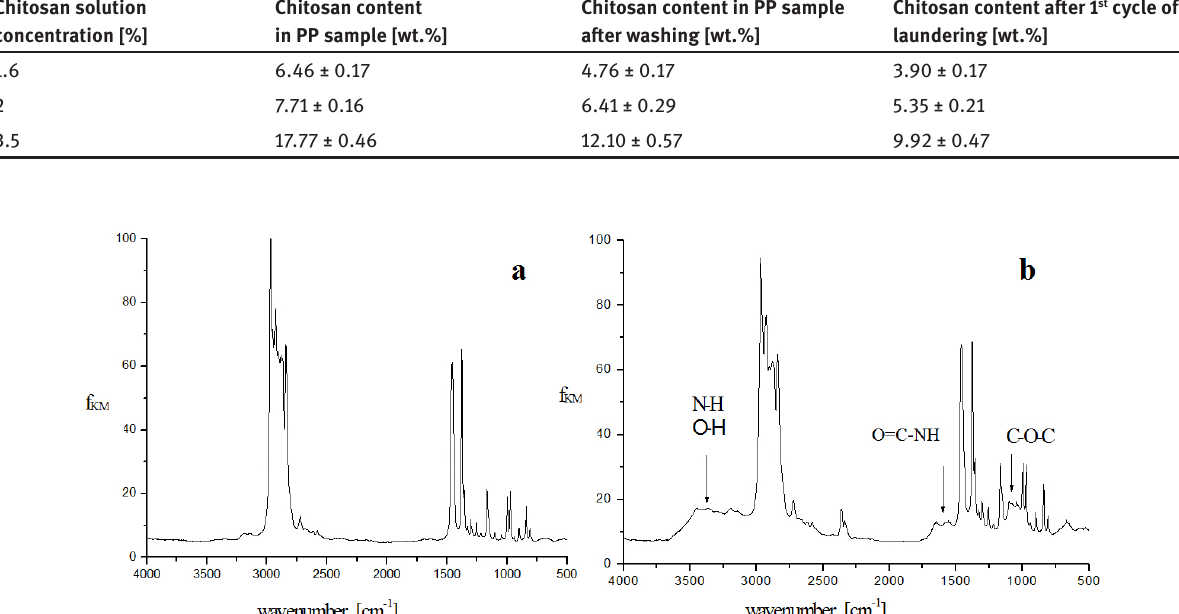
Chitosan solution concentration [%]